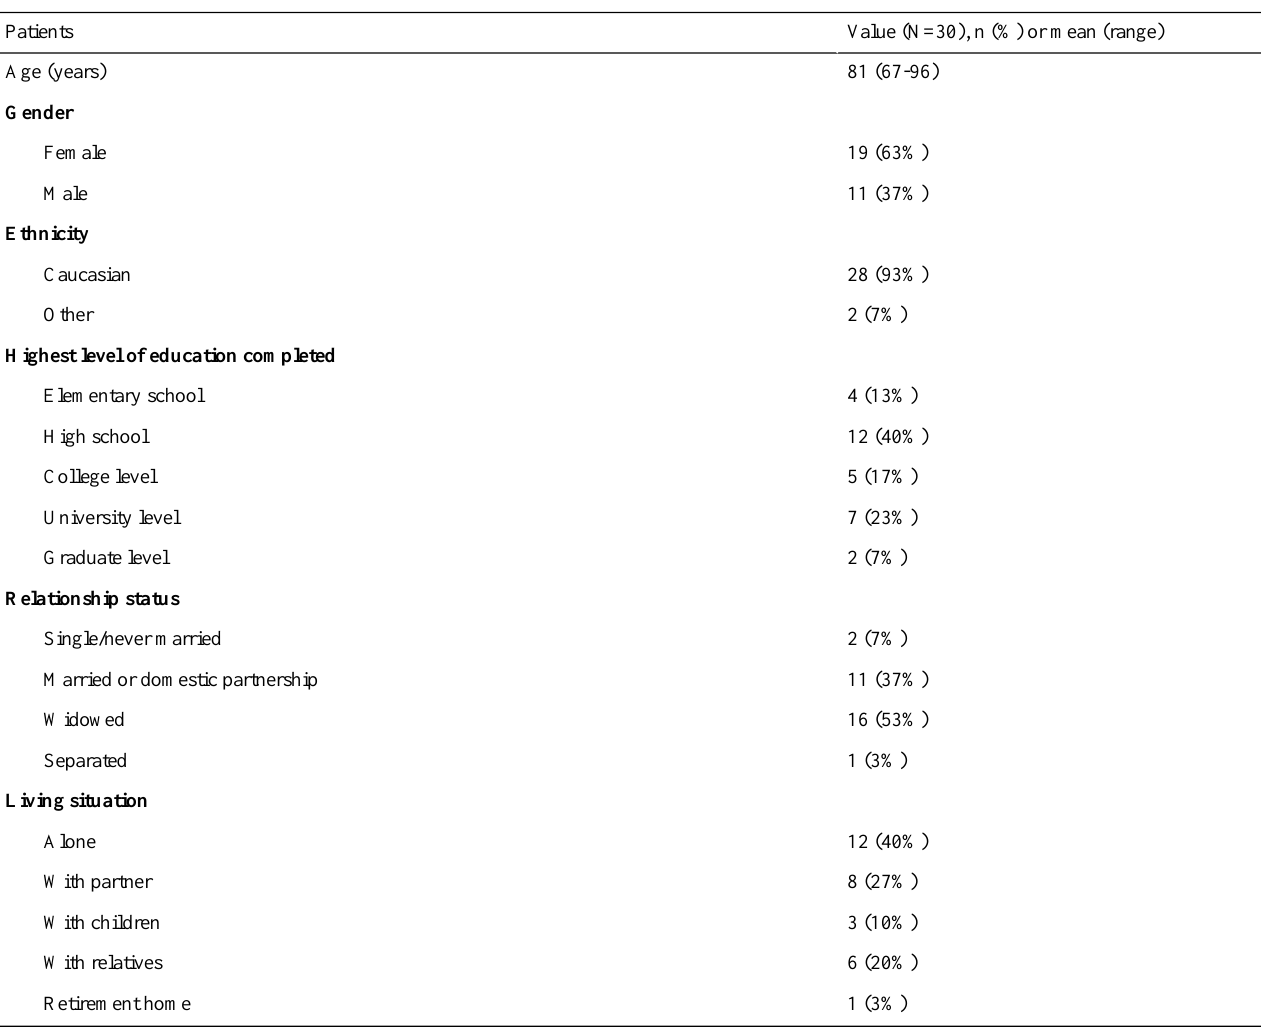
Table 3. Sociodemographic